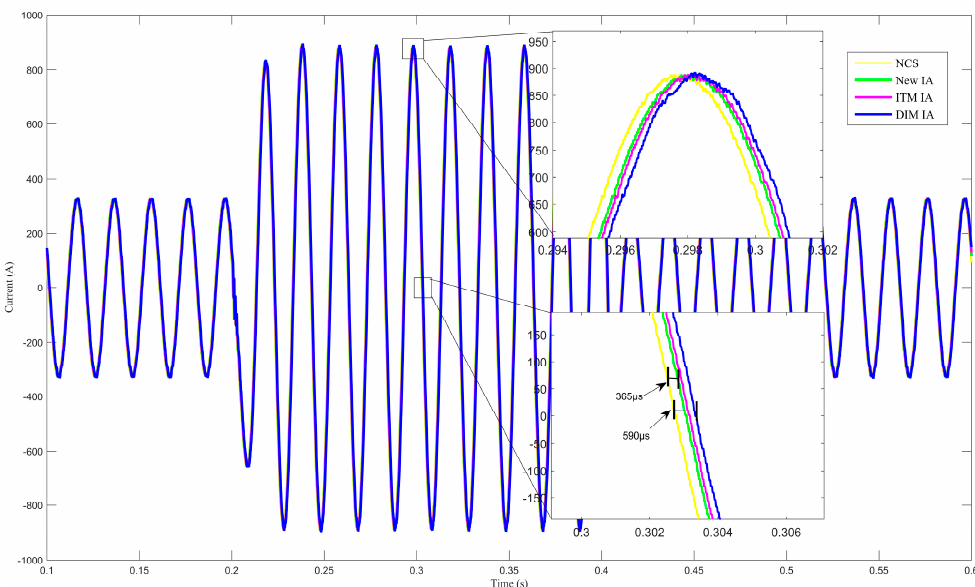
Figure 14. Grid-connected current waveform of RTISS with the new IA.